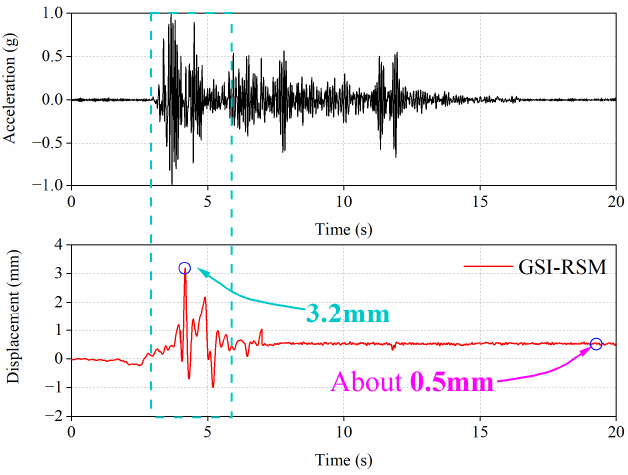
Figure 19. Relative displacement time–history curve.